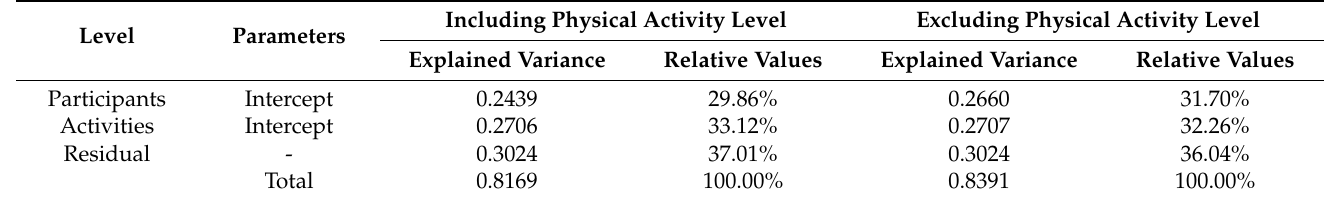
Table 3. Random effects of investigated levels on the intercept.